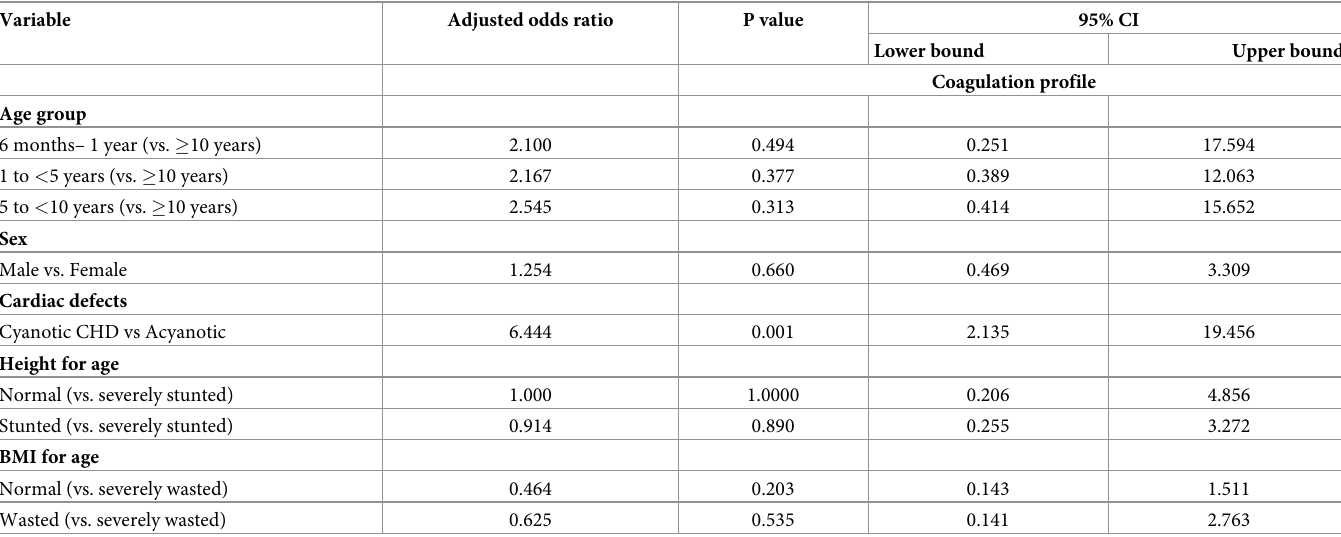
Table 8. Independent variables associated with coagulation abnormalities.